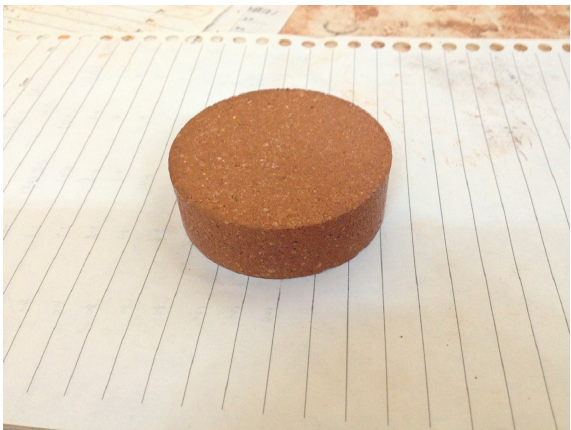
Figure 4: Sample after compaction.